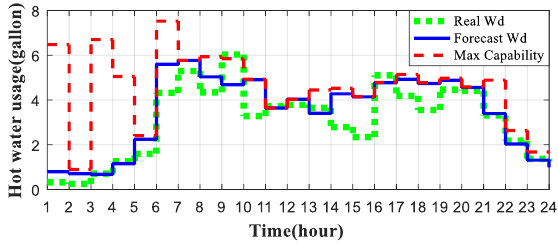
Figure 10. Comparison of EWH water demand and maximum capability.